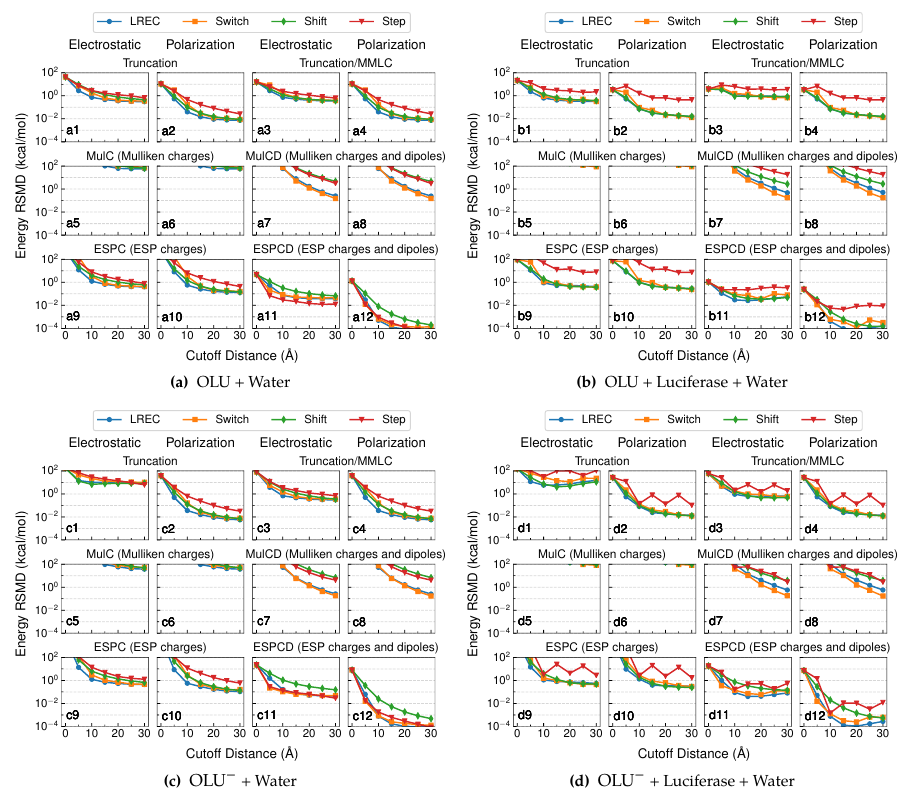
Figure 2. RMSD of electrostatic and polarization energies for neutral oxyluciferin in the ( a ) aqueous and ( b ) enzyme environments and anionic oxyluciferin in the ( c ) aqueous and ( d ) enzyme environments. All MM charges beyond a cutoff distance were removed from the QM/MM electrostatics calculation in the “Truncation” model, and the long-range electrostatics interaction between these far-field charges and the QM subsystem were described at the MM level in the “Truncation/MMLC” model. Near-field MM charges remained unchanged in the “Step” calculations, but scaled with the long-range electrostatic corrections (“LREC”), “Switch” and “Shift” calculations to ensure a continuous potential energy